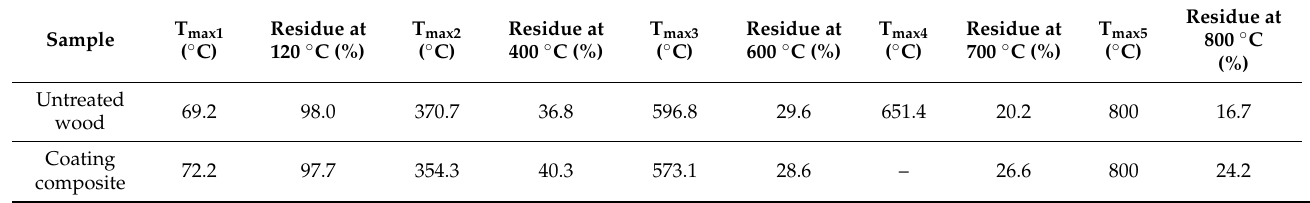
Figure 4. TGA curves ( a ) and DTG curves ( b ) for the untreated wood and coating composite. Table 1. Results of thermogravimetric analysis.